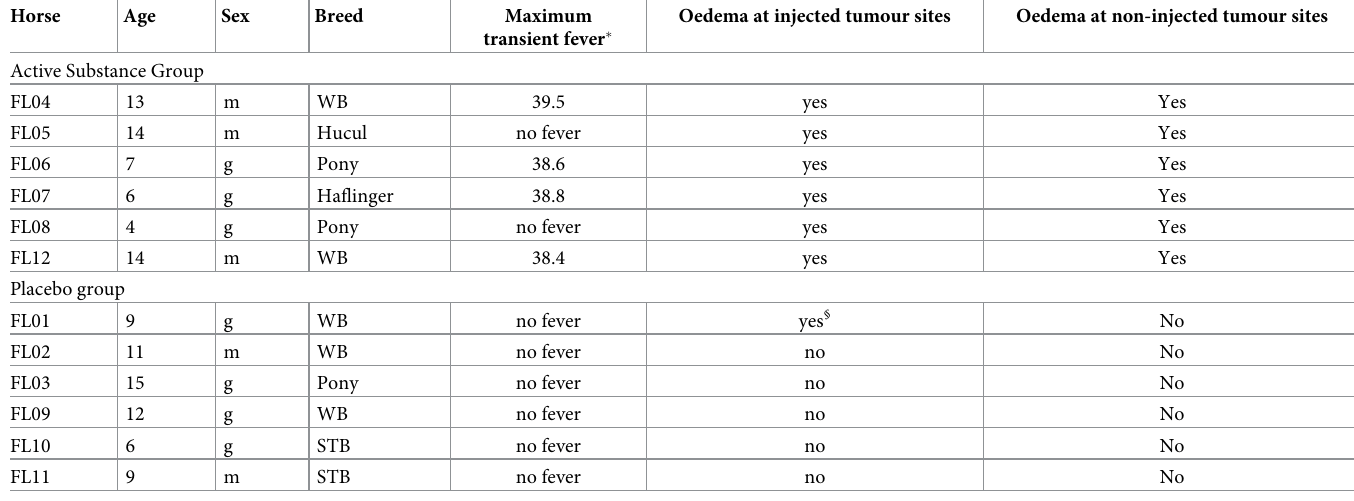
m: mare; g: gelding; WB: Warmblood horse; STB: Standardbred horse (Trotter). � > 38˚C; maximum duration < 24h, observed after first injection with iNSA/E6E7 equ only. § Resolved within 12 h (oedema in the “Active Substance Group” persisted for several